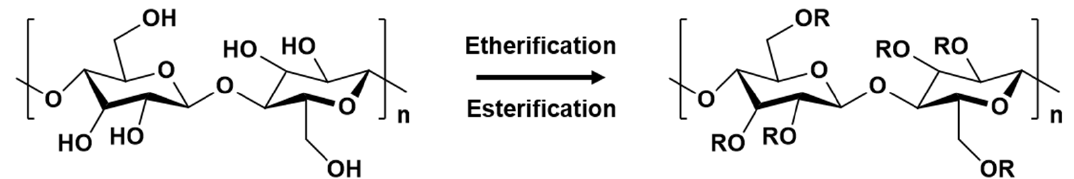
Figure 4. Cellulose is etherified or esterified to form cellulose derivatives .